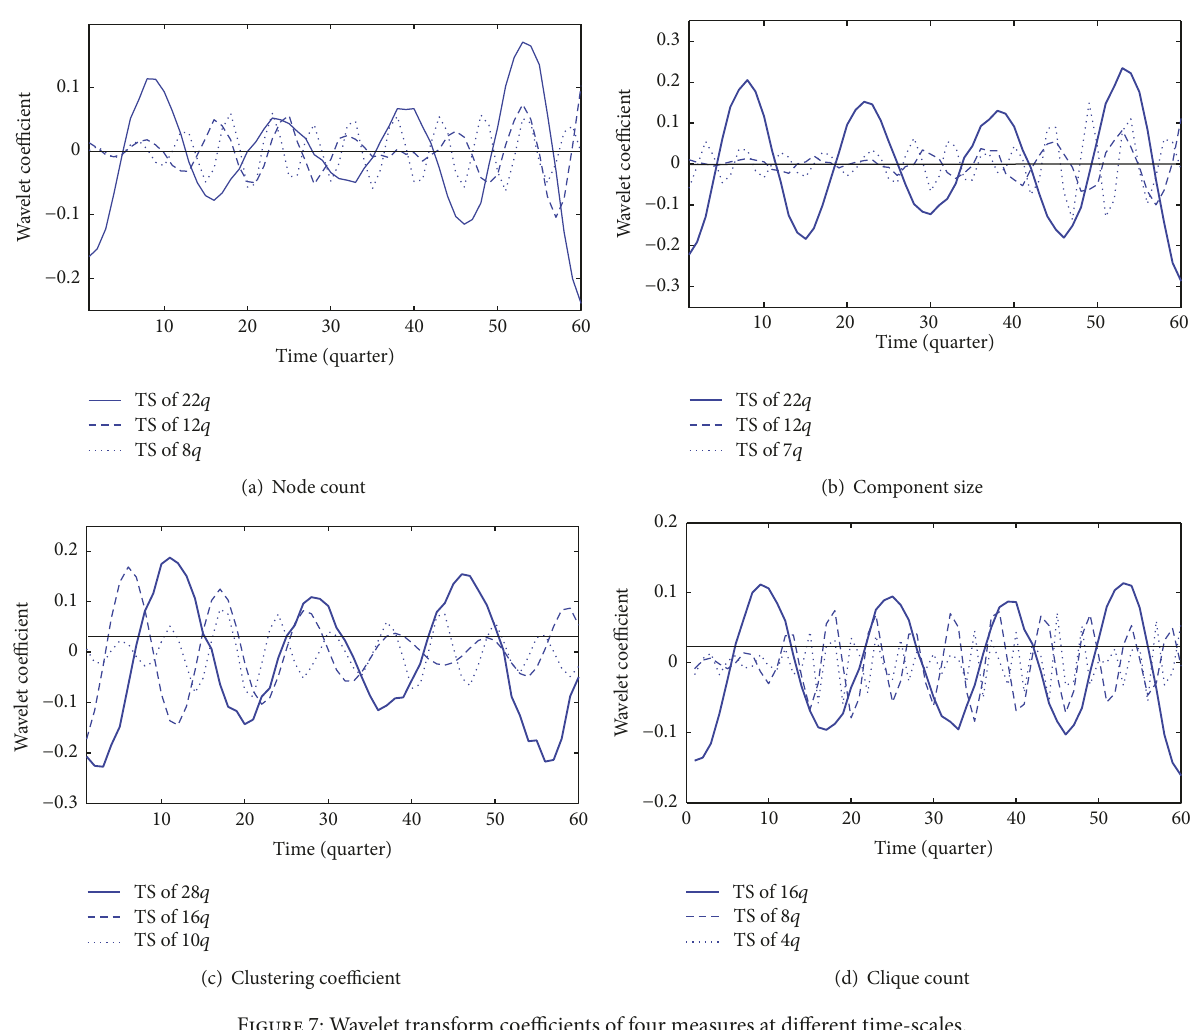
Figure 7: Wavelet transform coefficients of four measures at different time-scales. Table 3: Main periods and trend inference of the four